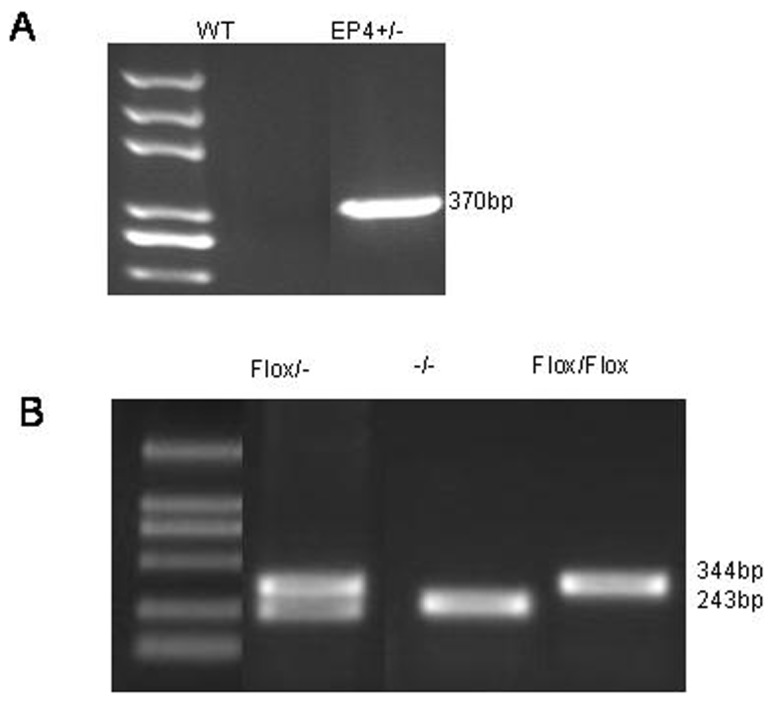
EP4+/− and EP4Flox/Flox mice identified.A. The exon 2 region of WT mice was not knockout and gene length was too long to have PCR product. The exon 2 region of EP4+/− mice was knockout and PCR product was 370 bp. B. PCR product of EP4Flox/Flox mice was 344 bp and WT mice was 243 bp.